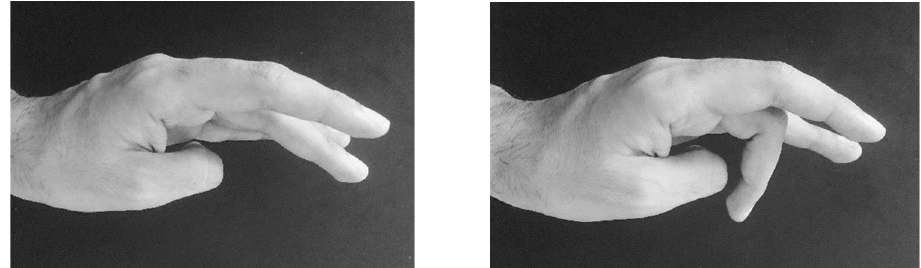
Figure 2. This patient suffers from an extremely rare combination of a blepharospasm with eye- opening dystonia, and an additional hemifacial spasm on the left side. Although the dose used for the left eye was highly reduced to 20% of the dose used for the right eye, a ptosis of the left eye occurred.